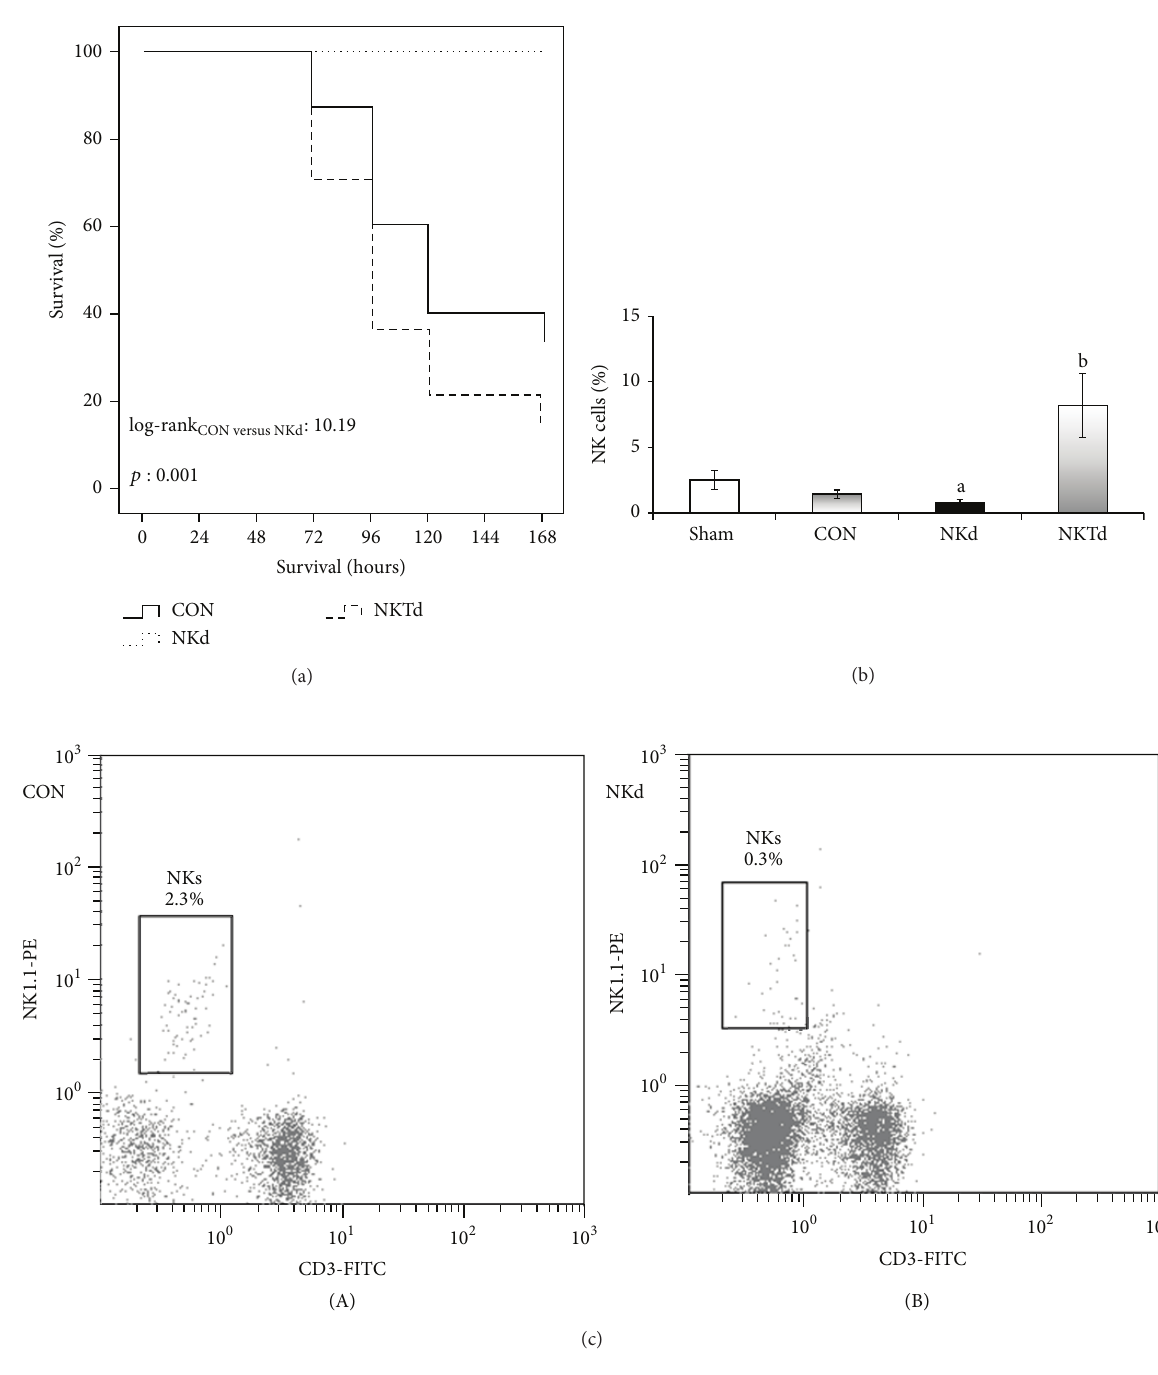
Figure 1: Kaplan-Meier survival plots. (a) Mice were intratracheally challenged with Streptococcus pneumoniae after pretreatment with nonspecific IgG (CON, 𝑛 = 15 ); after pretreatment with anti-asialo GM1 antibody (NKd, 𝑛 = 10 ); or after pretreatment with anti-CD1d antibody (NKTd, 𝑛 = 14 ). Survival was recorded for 7 days after bacterial challenge. Ten sham-operated mice (Sham) were also followed up : 10.19, 𝑝 : 0.001; log-rank : 1.96, 𝑝 : 0.161; and log-rank : 16.62; 𝑝 < 0.0001 . and none died. Comparisons log-rank CON VS NKd CON VS NKTd NKd VS NKTd (b) CD3 − /NK1.1+ cell populations among splenocytes from each group. Results come from 𝑛 = 5 per group at the time of sacrifice, 48 hours after bacterial challenge. 𝑝 of comparisons with sham-operated mice: a 0 . 018; b 0 . 030. (c) Data represent fluorescence-activated cell sorting plots obtained 48 hours after bacterial inoculation. Splenocytes were stained with fluorochrome labeled anti-NK1.1 and anti-CD3 monoclonal antibodies. CD3 − /NK1.1+ (NK) cell populations in (A) control and (B) anti-asialo GM1 treated animals are